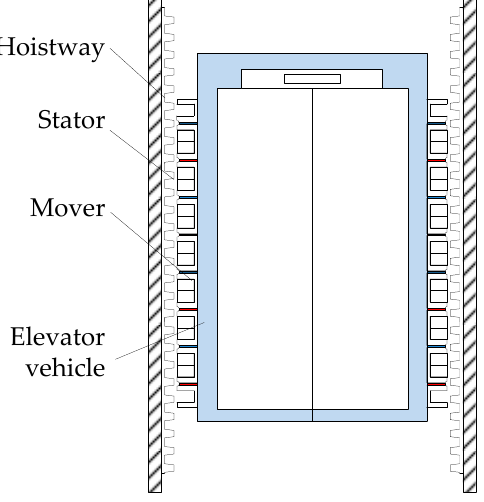
Figure 1. Direct drive elevator system.